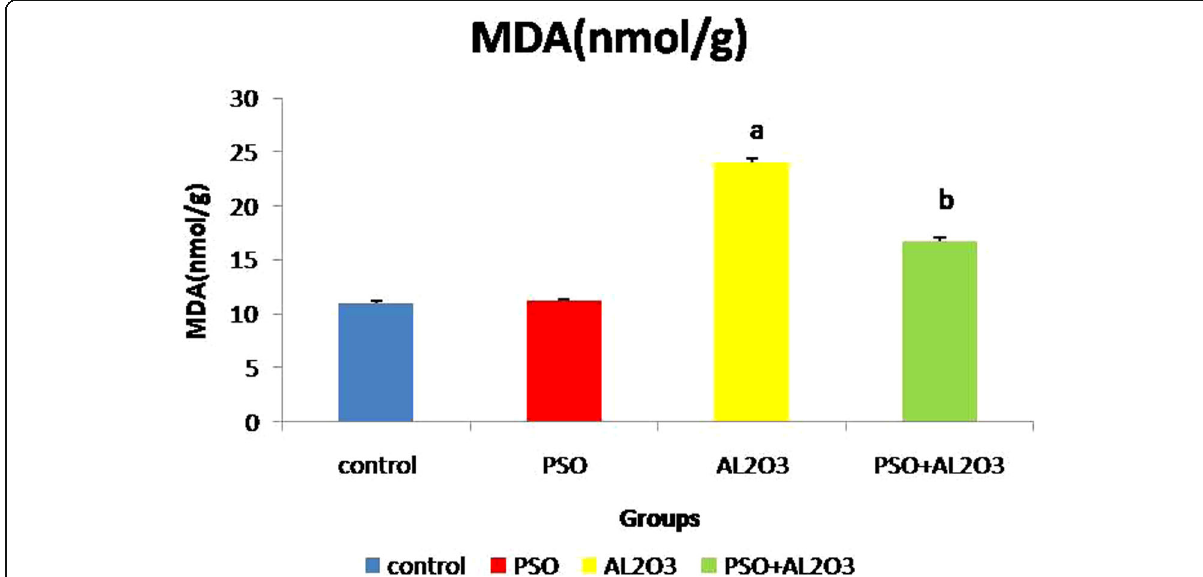
Fig. 4 Effect of pumpkin seed oil on lipid peroxidation (MDA level) in testicular tissue of AL 2 O 3 -NP administrated rat. (a) Significant change from the control rat. (b) Significant change from the AL 2 O 3 -NP-administrated